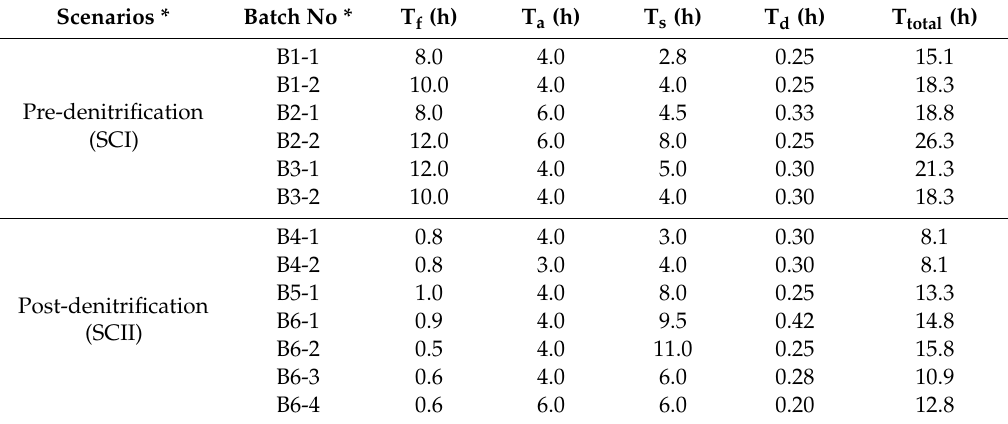
Table 2. Operational conditions of the pilot-scale SBR